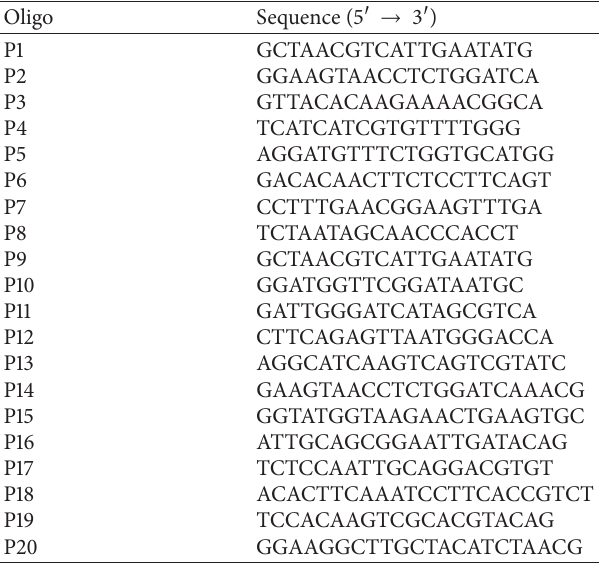
Table 2: Oligonucleotide primers used in this